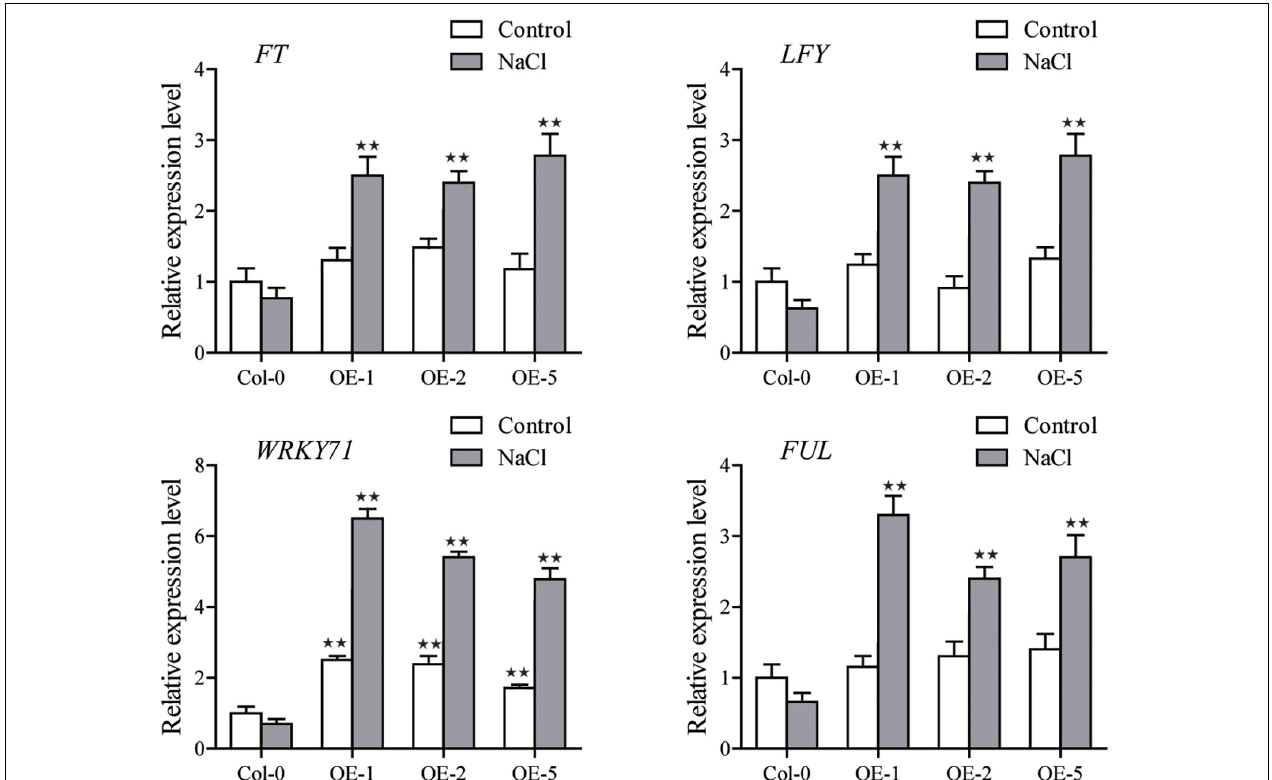
FIGURE 7 | The expression levels of FLOWERING LOCUS T ( FT ), LEAFY ( LFY ), and FRUITFULL ( FUL ) in Col-0 and SiGRF1-OE s under no stress or salt stress conditions. Values obtained by qPCR represent means ± SD from three biological replicates. Asterisks (* and **) indicate significant differences (* P < 0.05 and ** P < 0.01) compared with Col-0 (Student’s t-